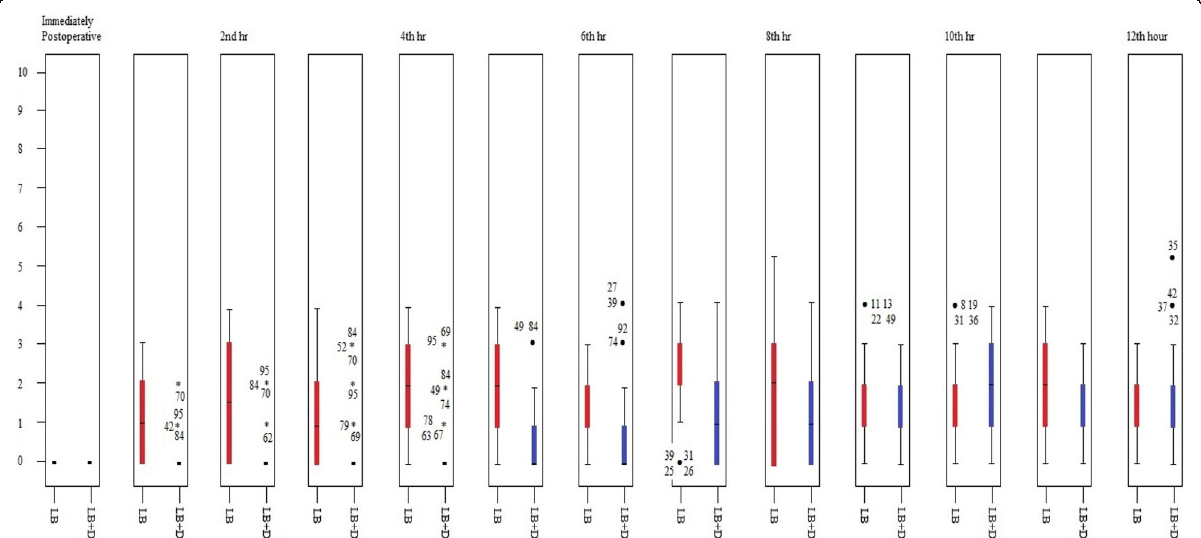
Fig. 2 The middle black solid line represents the median, the upper and lower margins of each box are the IQR, and the whiskers are maximum and minimum values. Asterisks (*) represent patient number with outlier data from LB group and dots ( ● ) represent patient number with outlier data from LB + D